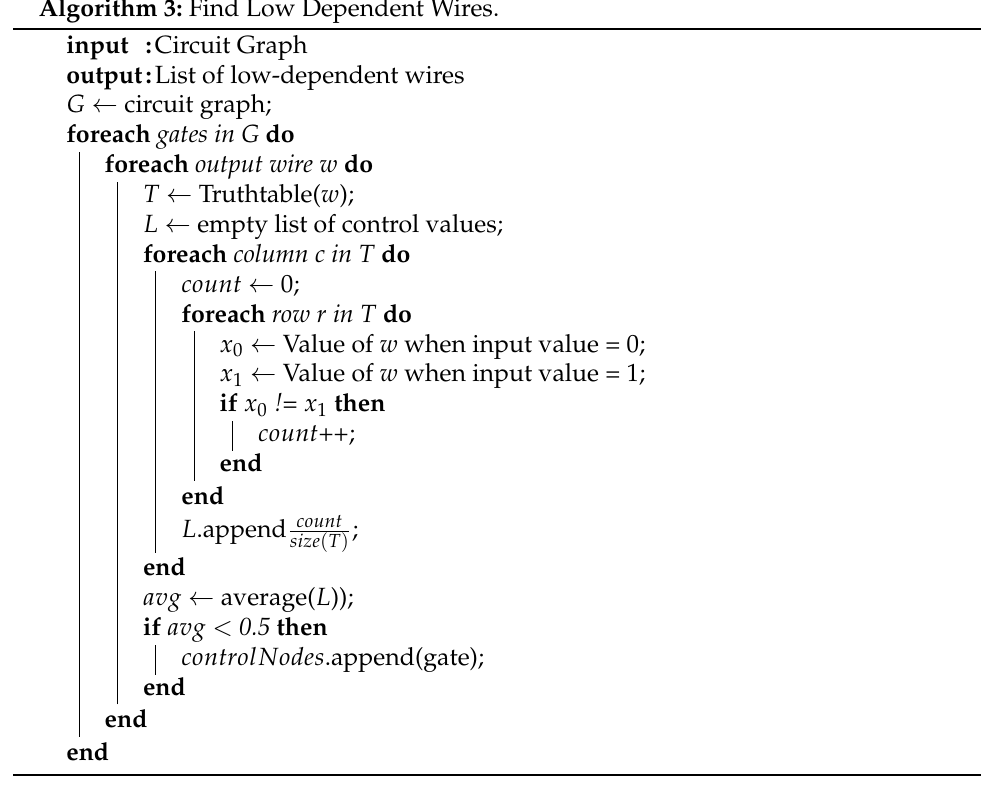
Algorithm 4: Find Biased Nodes.